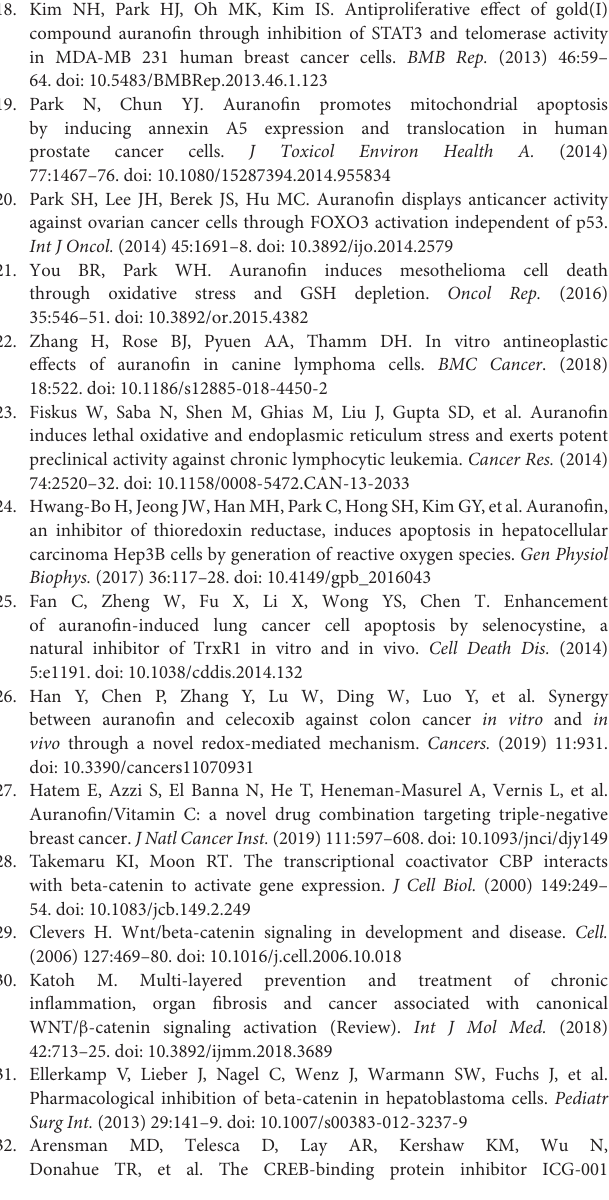
Supplementary Figure S1 | Autophagosomes of the CIPp cells in combination group. Arrows: autophagosome contained mitochondrion. (A) 20,000 × , bar = Supplementary Figure S2 | The drug toxicity assay of mice model. (A) The body weight of the xenograft tumor mice during drug treatment. (B) Histopathological examination (HE stain) of lung, liver, kidney, spleen, and heart from mice bearing with the xenograft tumor. Bar = 100 µ